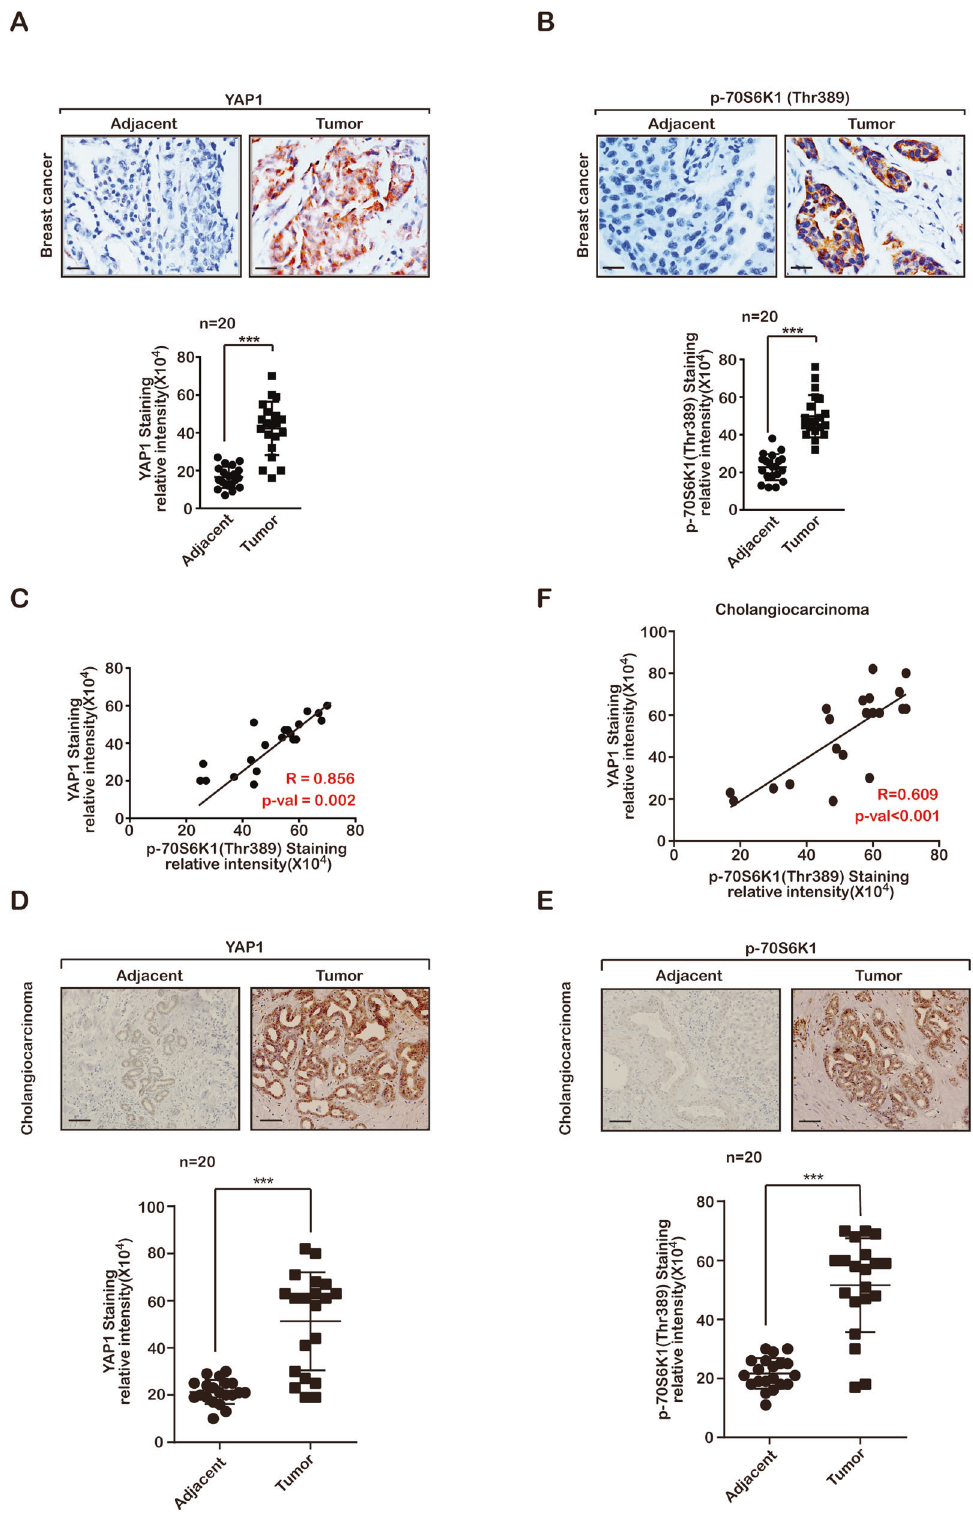
Fig. 2 Coactivation of the Hippo and mTORC1 pathways in cancer. a , b Immunohistochemical staining using antibodies against YAP1 ( a ) and phospho-p70S6K1 ( b ) in human breast cancer tissues. Upper panel: representative images (scale bars, 100 µm); lower panel: statistical analysis of immunohistochemical staining (*** P < 0.001). The results are the mean ± s.e.m. of n = 3 independent experiments. P values were determined by one-way ANOVA. c Pearson ’ s correlation analysis comparing staining density between YAP1 and phospho-p70S6K1, n = 20. d , e Immunohistochemical staining using antibodies against YAP1 ( d ) and phospho-p70S6K1 ( e ) in human cholangiocarcinoma tissues. Upper panel: representative images (scale bars, 400 µm); lower panel: statistical analysis of immunohistochemical staining (*** P < 0.001). The results are the mean ± s.e.m. of n = 3 independent experiments. P values were determined by one-way ANOVA. f Pearson ’ s correlation analysis comparing staining density between YAP1 and phospho-p70S6K1, n = 20. Cell Death and Disease (2021)